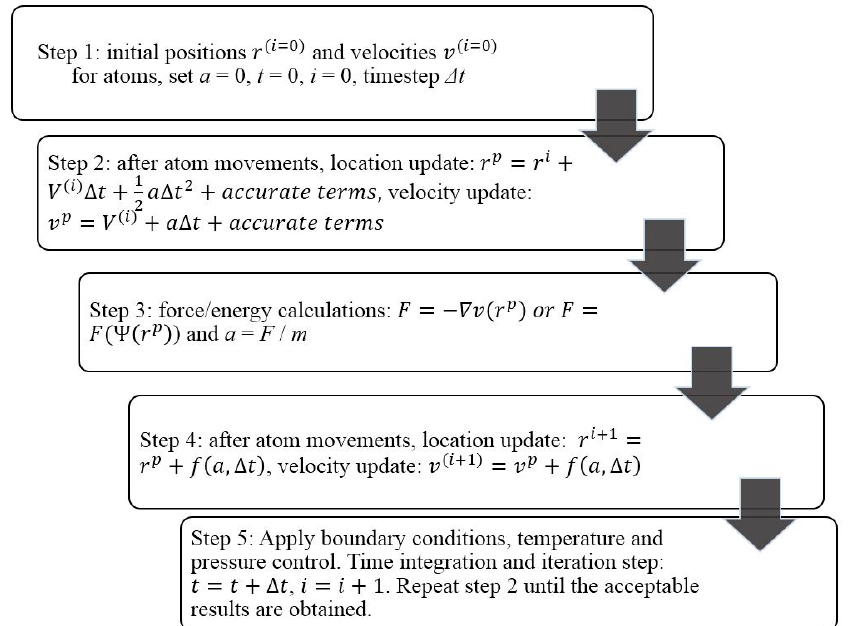
Figure 1. Computation algorithm of Molecular Dynamics (MD)